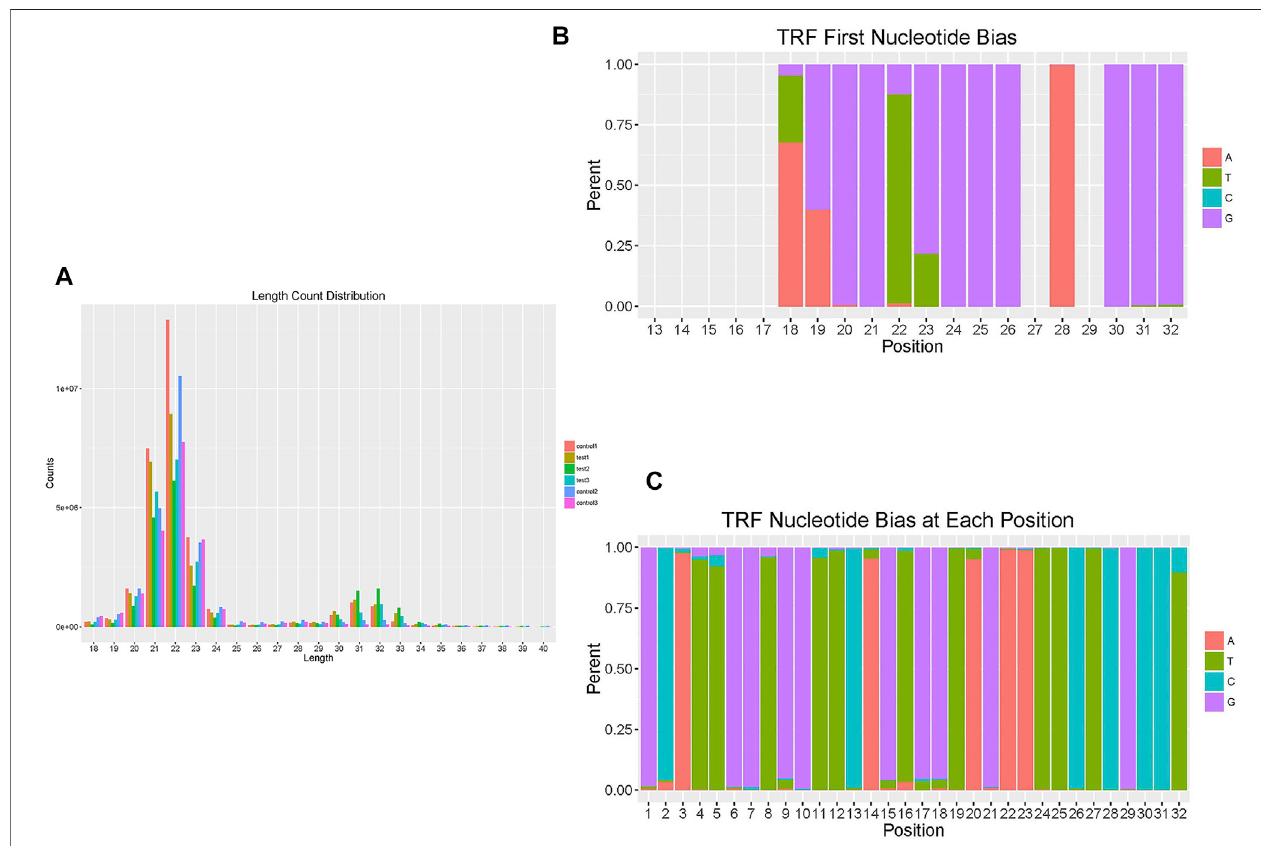
FIGURE2| OverviewofthereadlengthandpositiondistributionoftRFsintheTAOgroupandthenormalgroup. (A) Thebarchartshowsthereadcountsandread lengthineachsampletoillustratethereadlengthdistribution. (B) Thebarchartshowsthebasedistributionofthe fi rstpositionoftRFsofdifferentlengths.Theabscissais the length of the tRFs, and the ordinate is the percentage of A/U/C/G as the fi rst base. (C) The bar chart shows the base distribution of each position of tRFs. The abscissa is the base position of tRFs, and the ordinate is the percentage of the bases A/U/C/G at that position.